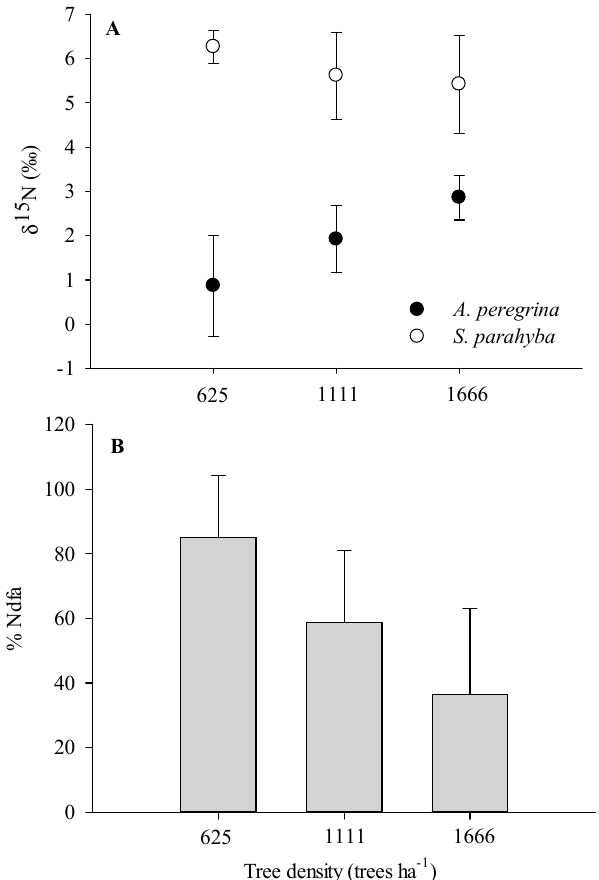
Figure 2. ( A ) δ 15 N (‰) in leaves of A. peregrina and S. parahyba under three different stand densities, and ( B ) Percentage of N 2 derived from fixation (%Ndfa) by A. peregrina , under three different stand densities. Vertical bars indicate the standard deviation of the mean (N = 3).